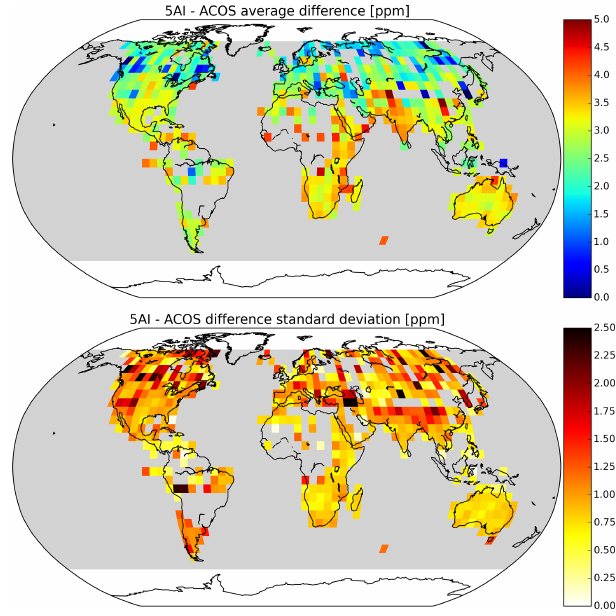
Figure 5. Spatial repartition of 5AI difference with the raw ACOS B8r (average and standard deviation) on 5 ◦ × 5 ◦ square bins for the nadir data